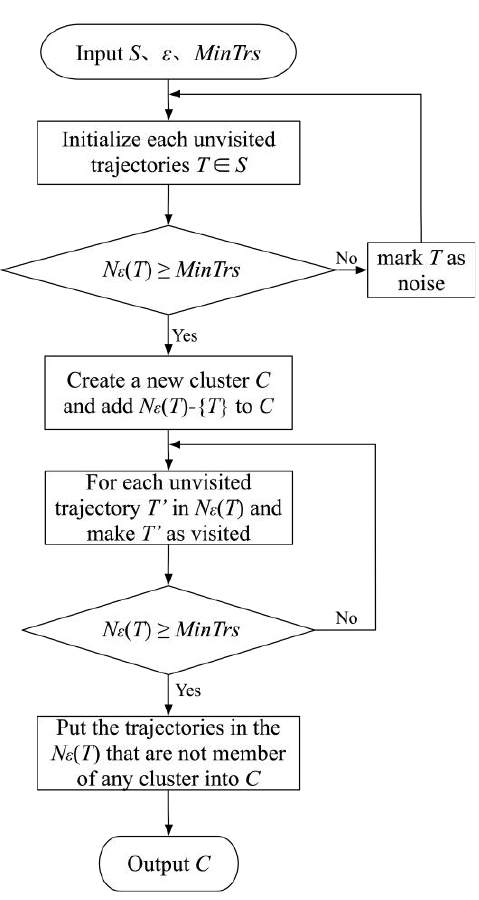
Figure 5. DBSCAN-based ship trajectory clustering algorithm.